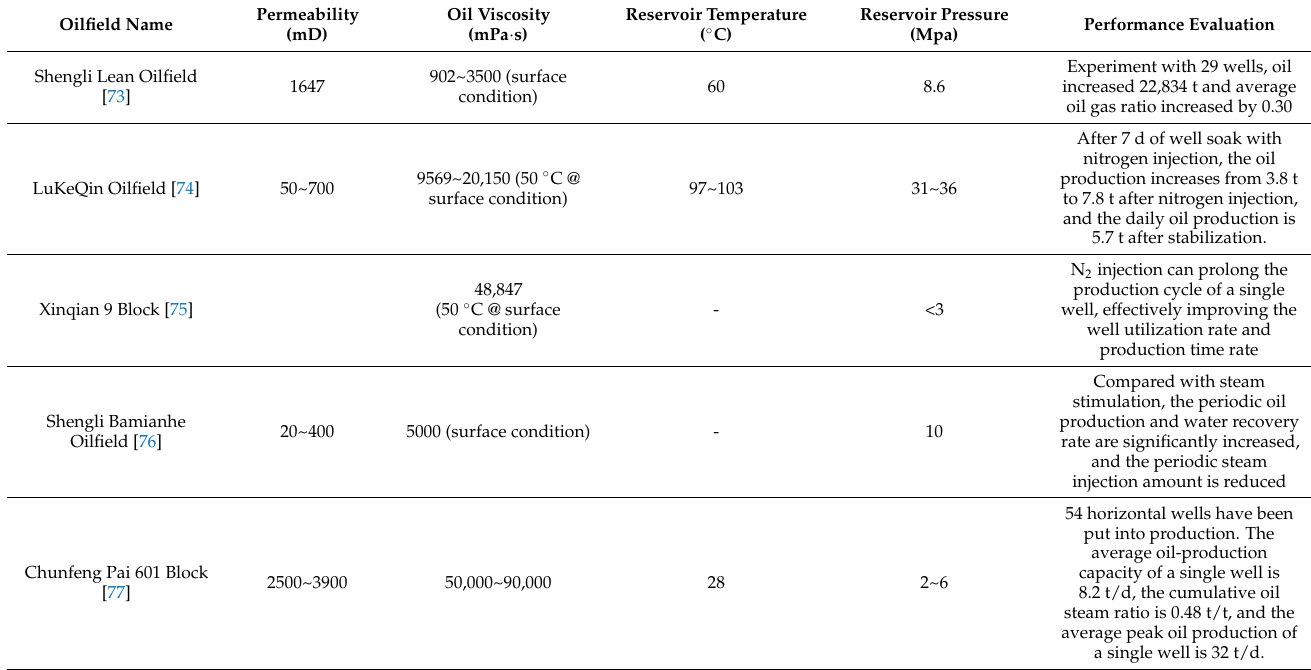
Table 3. Field application of N 2 -assisted steam